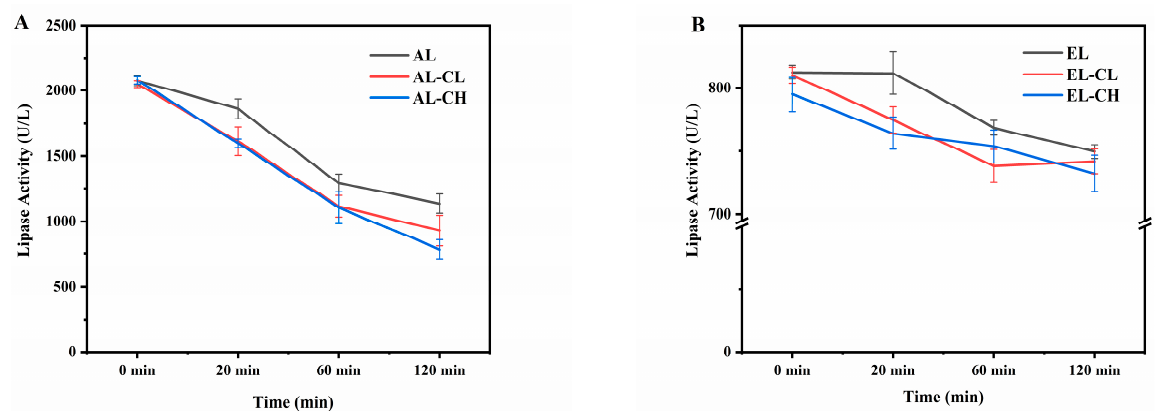
Figure 4. Lipase activity during in vitro ( A ) adult and ( B ) infant intestinal digestion. Data were shown as mean ± SD of three replicates.